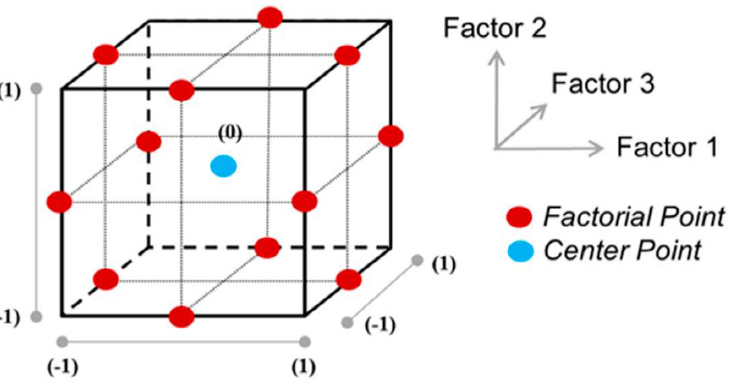
Figure 5. The layout of Box – Behnken design with three factors [103].